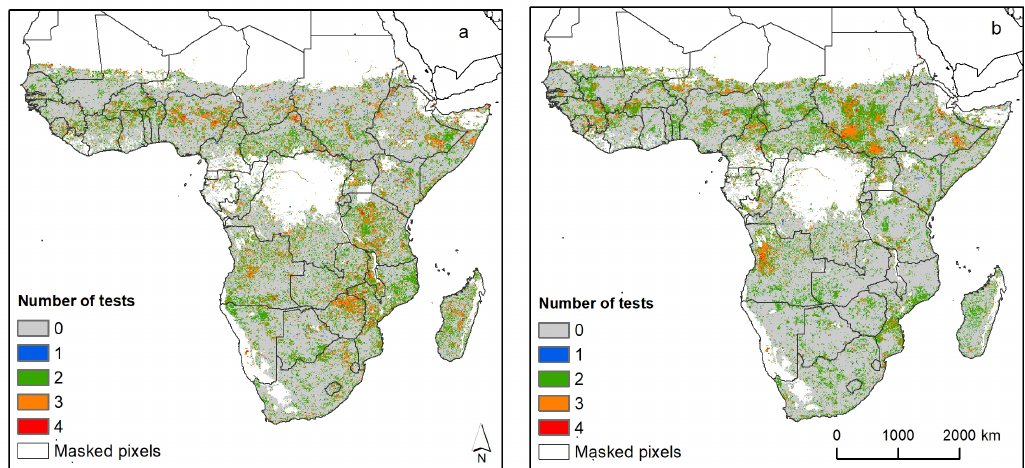
Figure 5. Number of structural change tests that identified a significant ( p < 0.05) breakpoint for: ( a ) NDVI, and ( b )